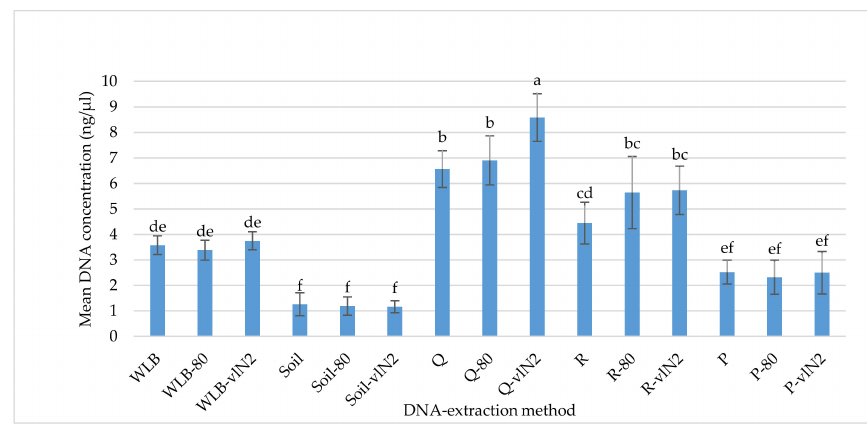
Figure 2. Concentrations of DNA extracted from 4000 nematodes using 15 DNA-extraction procedures combining five methods (WLB = adapted Holterman method; soil = Soil DNA Isolation Kit, Norgen Biotek; Q = Qiagen method; R = High Pure PCR Template Prep Kit, Roche; and P = Wizard Magnetic DNA Purification System for Food, Promega) with either no pre-treatment (no suffix), cooling at − 80 ◦ C (suffix-80) or liquid nitrogen (suffix vlN2). Error bars indicate the standard deviation ( n = 5). Different letters on top of the bars represent significant differences between the DNA-extraction procedures ( p < 0.001). More details can be found in Supplementary File